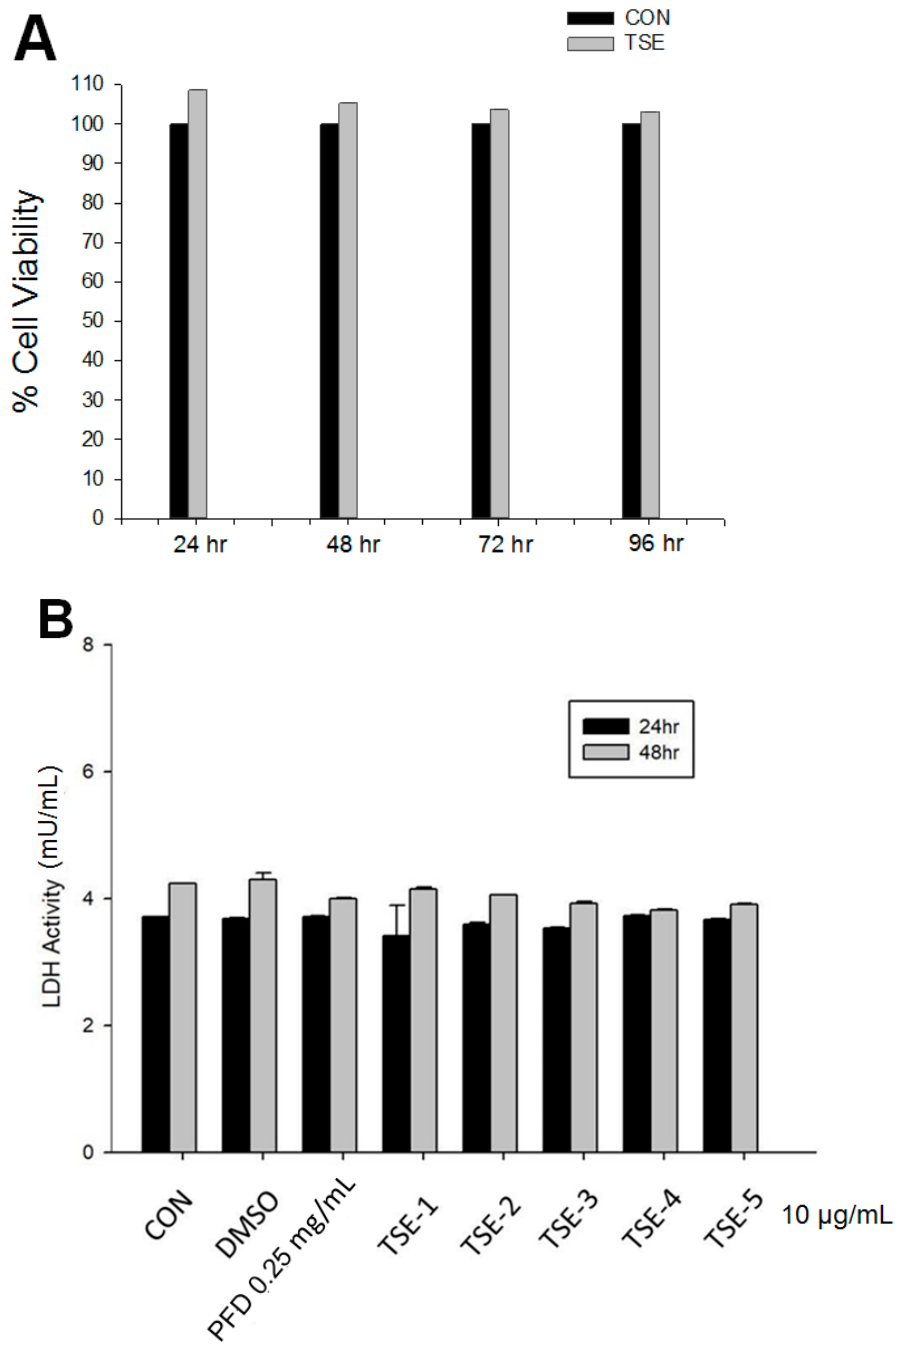
Figure 3. Cell viability and cytotoxicity. ( A ) Cell viability of 2-phenyl-5-propyl- DHPO (TSE; TSE-2). Following treatment with TSE at 24, 48, 72, or 96 h time, there was no significant difference between TSE treated and the CON. Data are the mean ±SE (n = 3). ( B ) Cytotoxicity of five compounds of DHPO derivatives. Following treatment with five compounds at 24 or 48 h time, no significant difference was found between five compounds treated and the CON group. Values are the mean ± SE (n = 3).